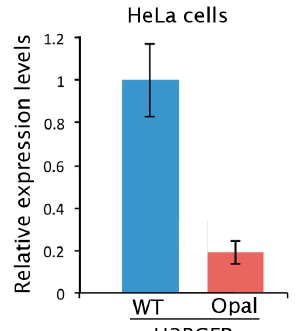
Figure 4. H2BGFP gene expression levels measured by RT-qPCR in HeLa-H2BGFP WT and H2BGFP opal cells. The histogram represents the mean ± SD of a quadruplicate.